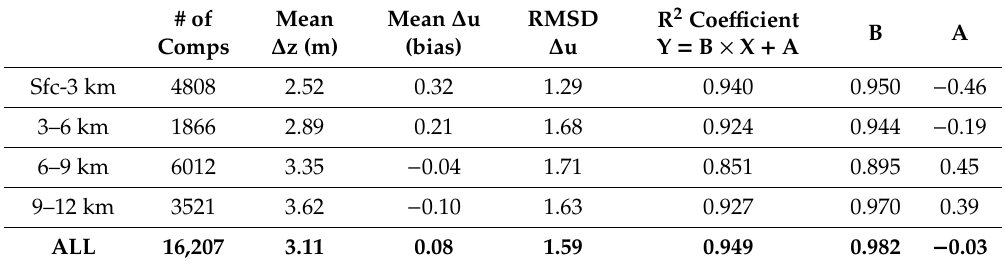
Table 8. DAWN-dropsonde comparison statistics by height for u component of the horizontal wind.